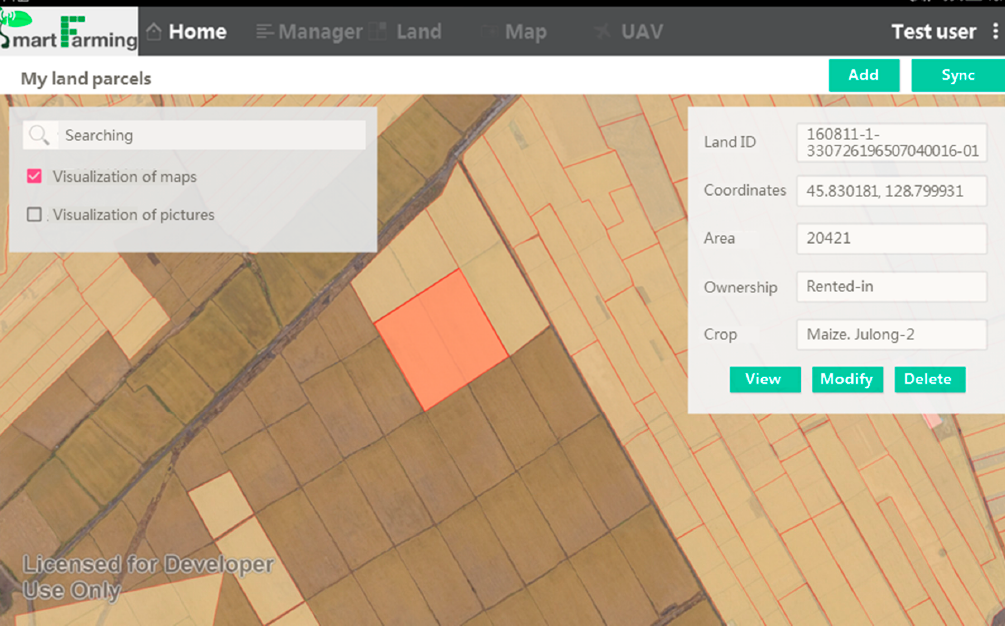
Figure 5. Visualization of land activities on a land parcel.